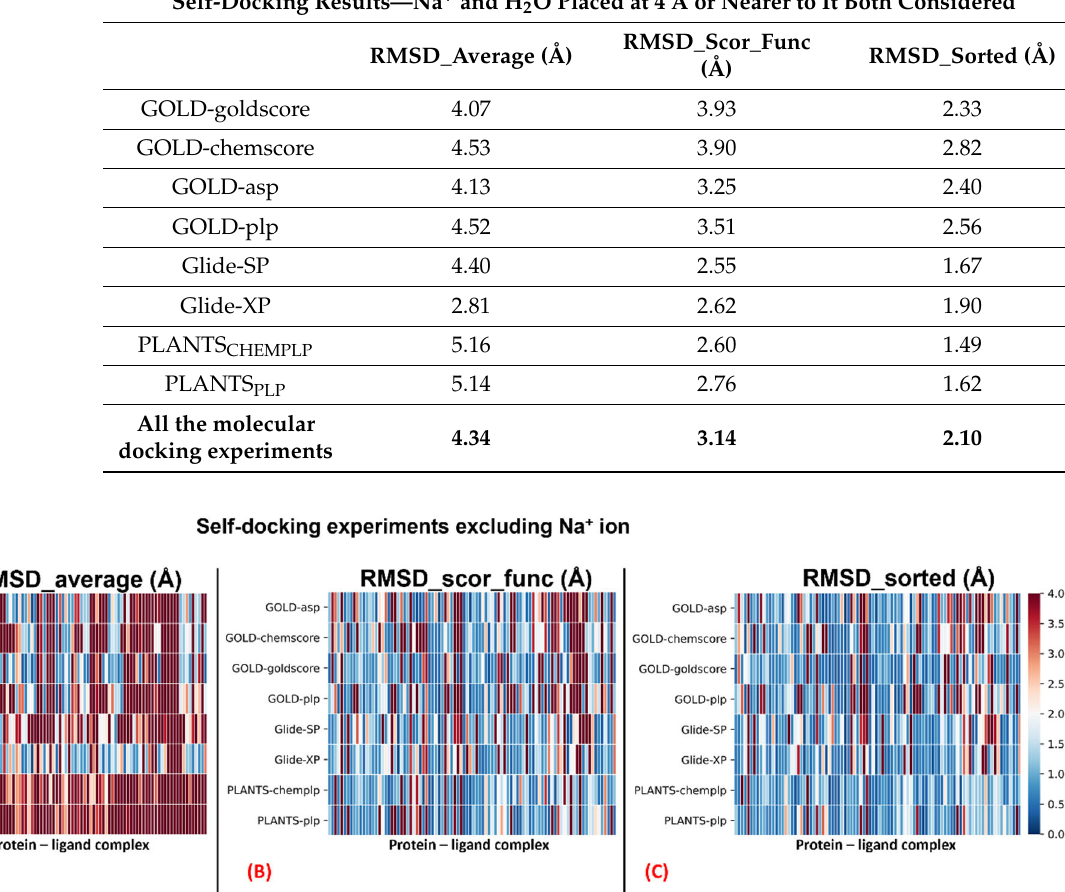
Figure 1. Colormaps show the results of the self-docking calculations not considering the sodium ion within the GPCR receptor 7TM region of the 118 complexes examined in this study. The three plots depict respectively: ( A ) the outcomes derived from the average of the RMSDs of all the poses for each docking run (“RMSD_average”); ( B ) the results obtained just from the RMSD between the crystallo- graphic ligand coordinates and the best-ranked pose from the scoring function (“RMSD_scor_func”); ( C ) the results of the self-docking experiments if just the pose showing the best RMSD value between its coordinates and the crystallographic ones are considered (“RMSD_sorted”). The x-axis enumer- ates all the different GPCR–antagonist complexes, which are plotted against the different docking program–scoring function pairs used for our study, reported on the